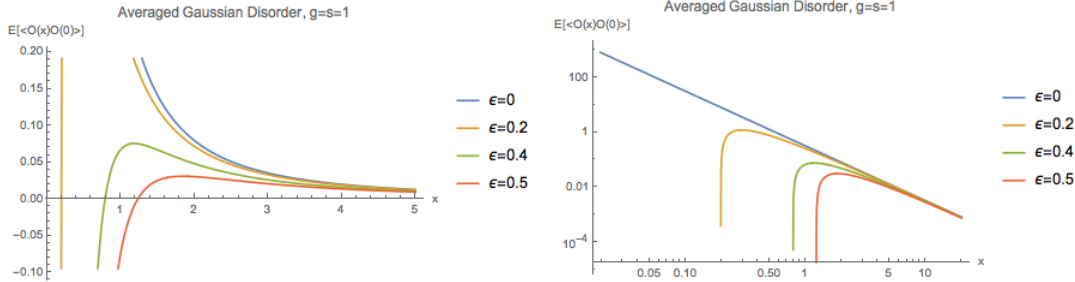
Figure 5 . Averaged two-point function eq. (3.54) for oscillating geometry disordered Gaussian geometry for di(cid:11)erent disorder strength (cid:15) . The plot on the right is the same as the one in the left, but in log-log